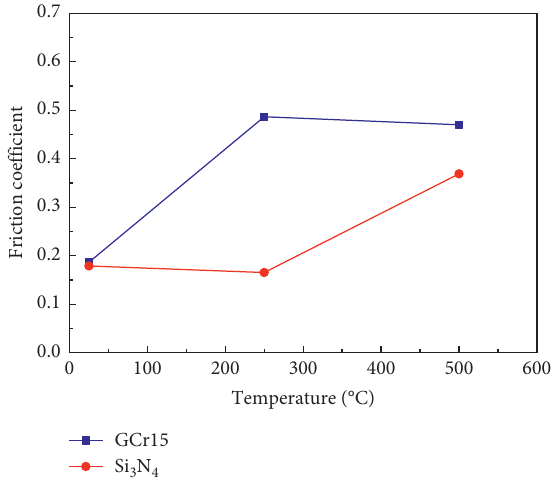
Figure 3: Evolution of friction coefficients between Inconel 625 disk and Si 525mm/s. The macroscopic morphology of the wear mark by (a) GCr15 grinding and (b) Si 3 N 4 grinding.